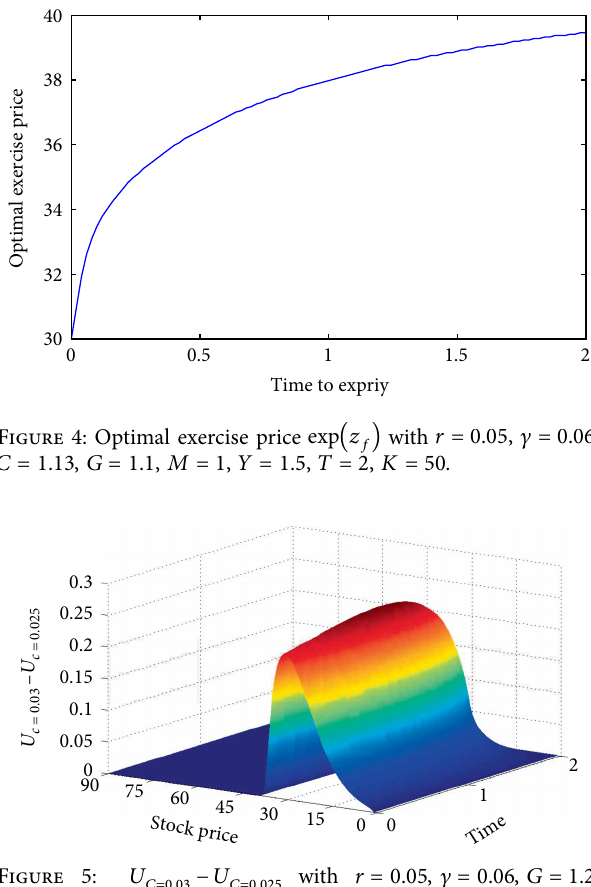
Figure 5: 𝑈 𝐶=0.03 − 𝑈 𝐶=0.025 𝑀 = 1, 𝑌 = 1.5, 𝑇 = 2, 𝐾 = 50